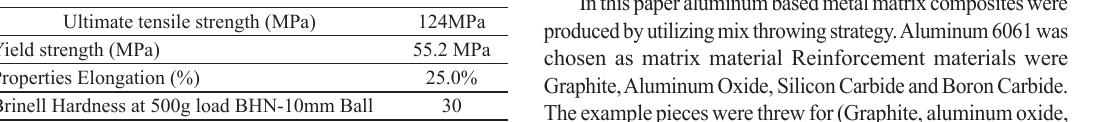
Table 1. Mechanical Properties of 6061